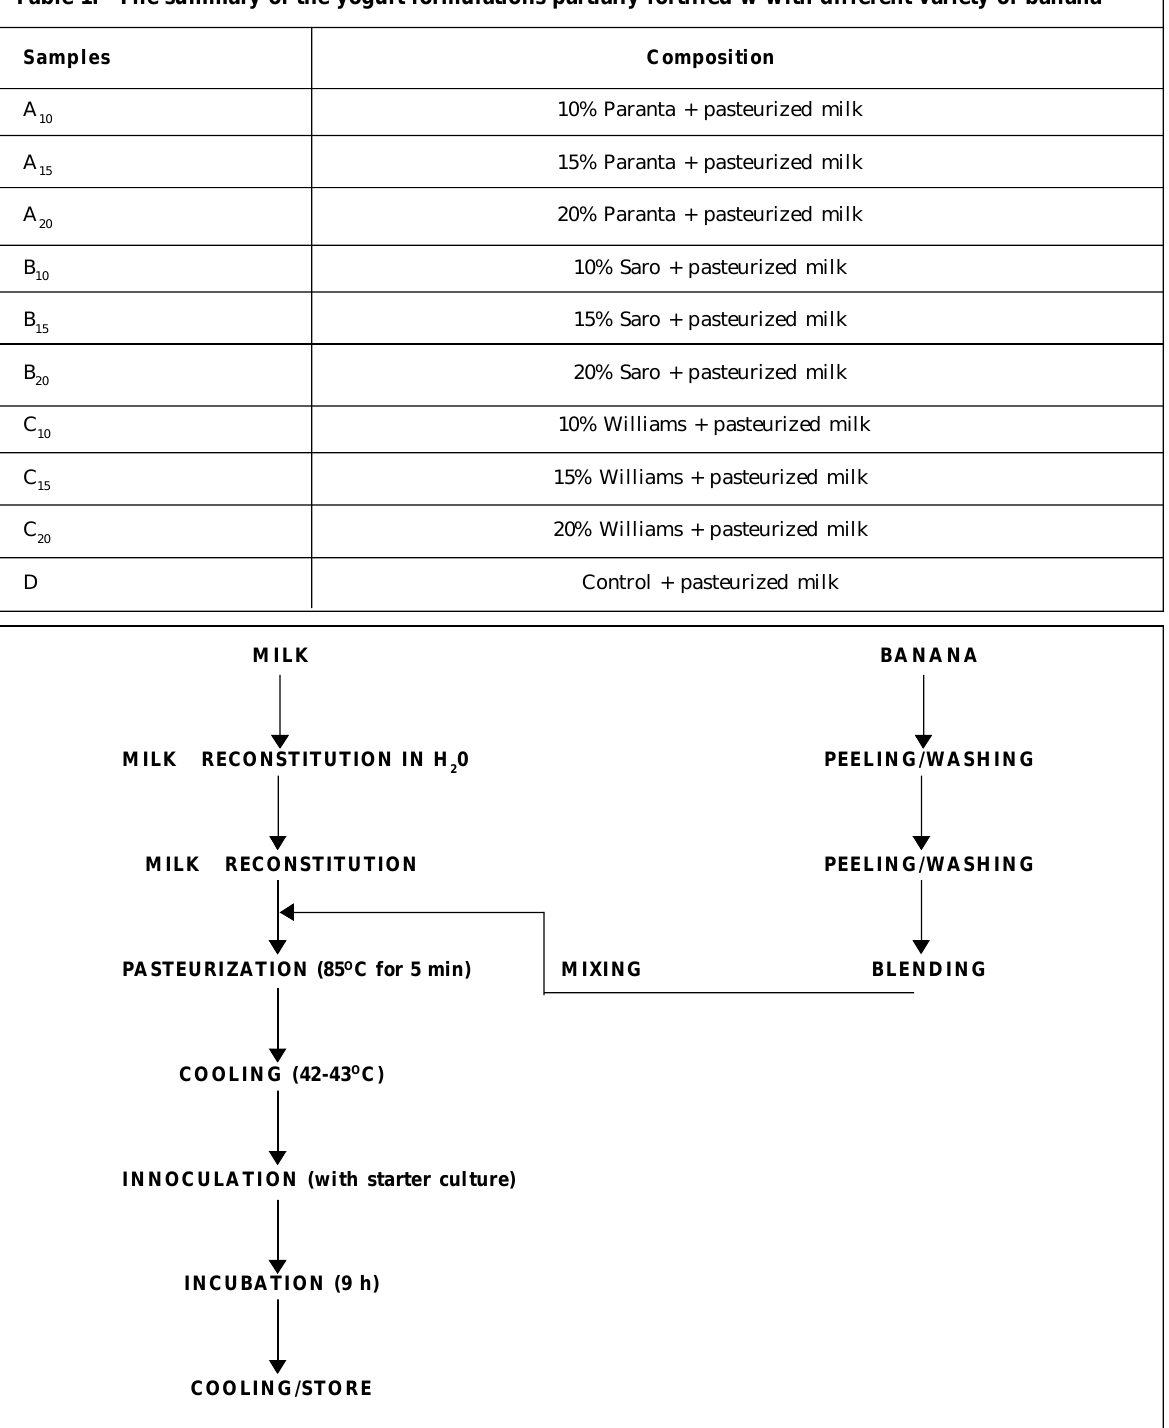
Table 1: The summary of the yogurt formulations partially fortified w with different variety of banana Samples